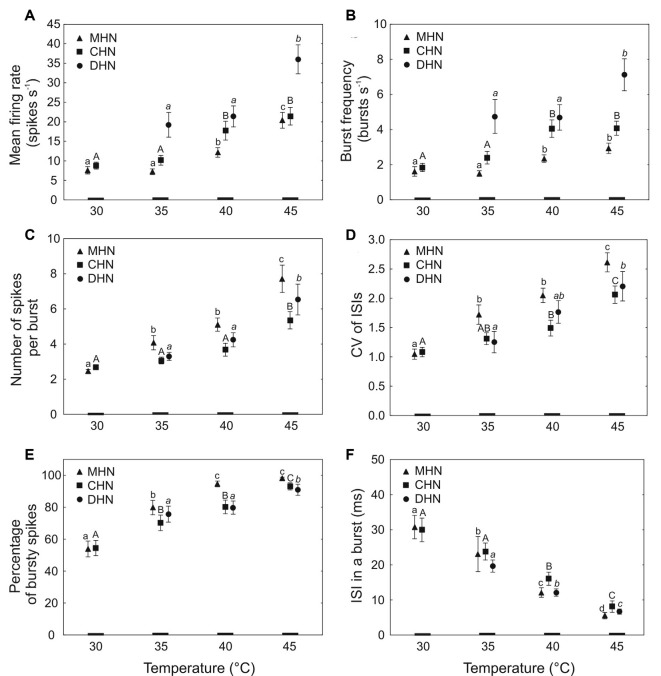
Dependence of bursty spike train parameters (mean ± standard error) of the antennal DSS neurons on temperature (A–F). Different lowercase normal, uppercase normal, and lowercase italic letters show significant differences between the means at P < 0.05 (Kruskal–Wallis test) for the MHN, CHN, and DHN, respectively. The number of tested insects (N) for each data point = 17–30. CV, coefficient of variation; ISI, inter-spike interval.